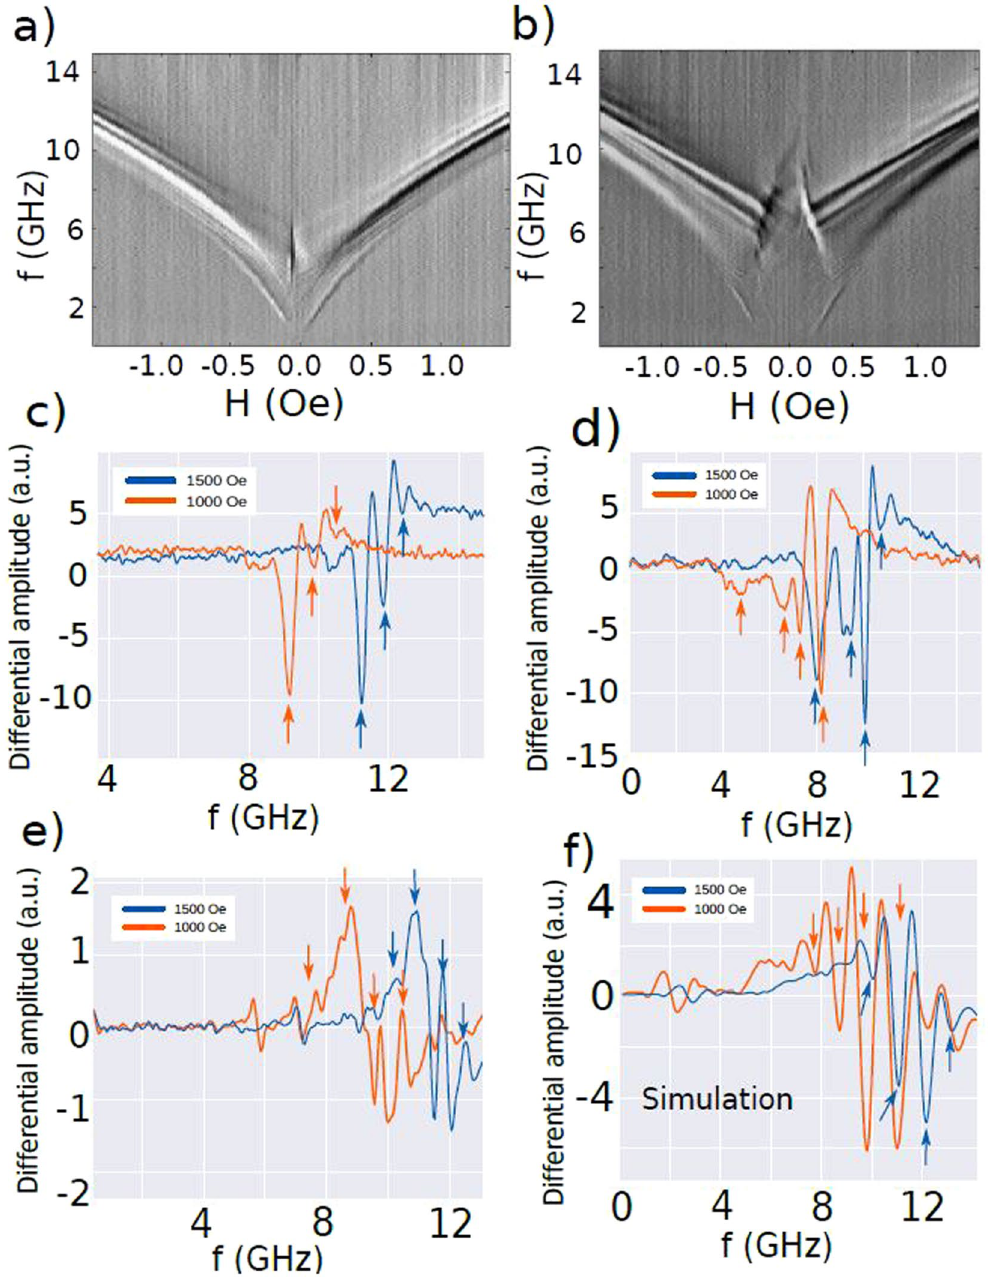
Figure 7. Experimentally measured microwave permeability as a function of driving frequency and in-plane DC magnetic field for 2 μ m triangular permalloy dots with thickness of ( a ) 30 nm and ( b ) 100 nm. ( c , d ) Show two cross sections of the spectra ( a , b ) respectively. ( e , f ) Show the simulated excitation spectra of a 2 μ m triangular dot (30 nm and 100 nm thick, respectively) for two different applied fields. Arrows indicate some of the strongest